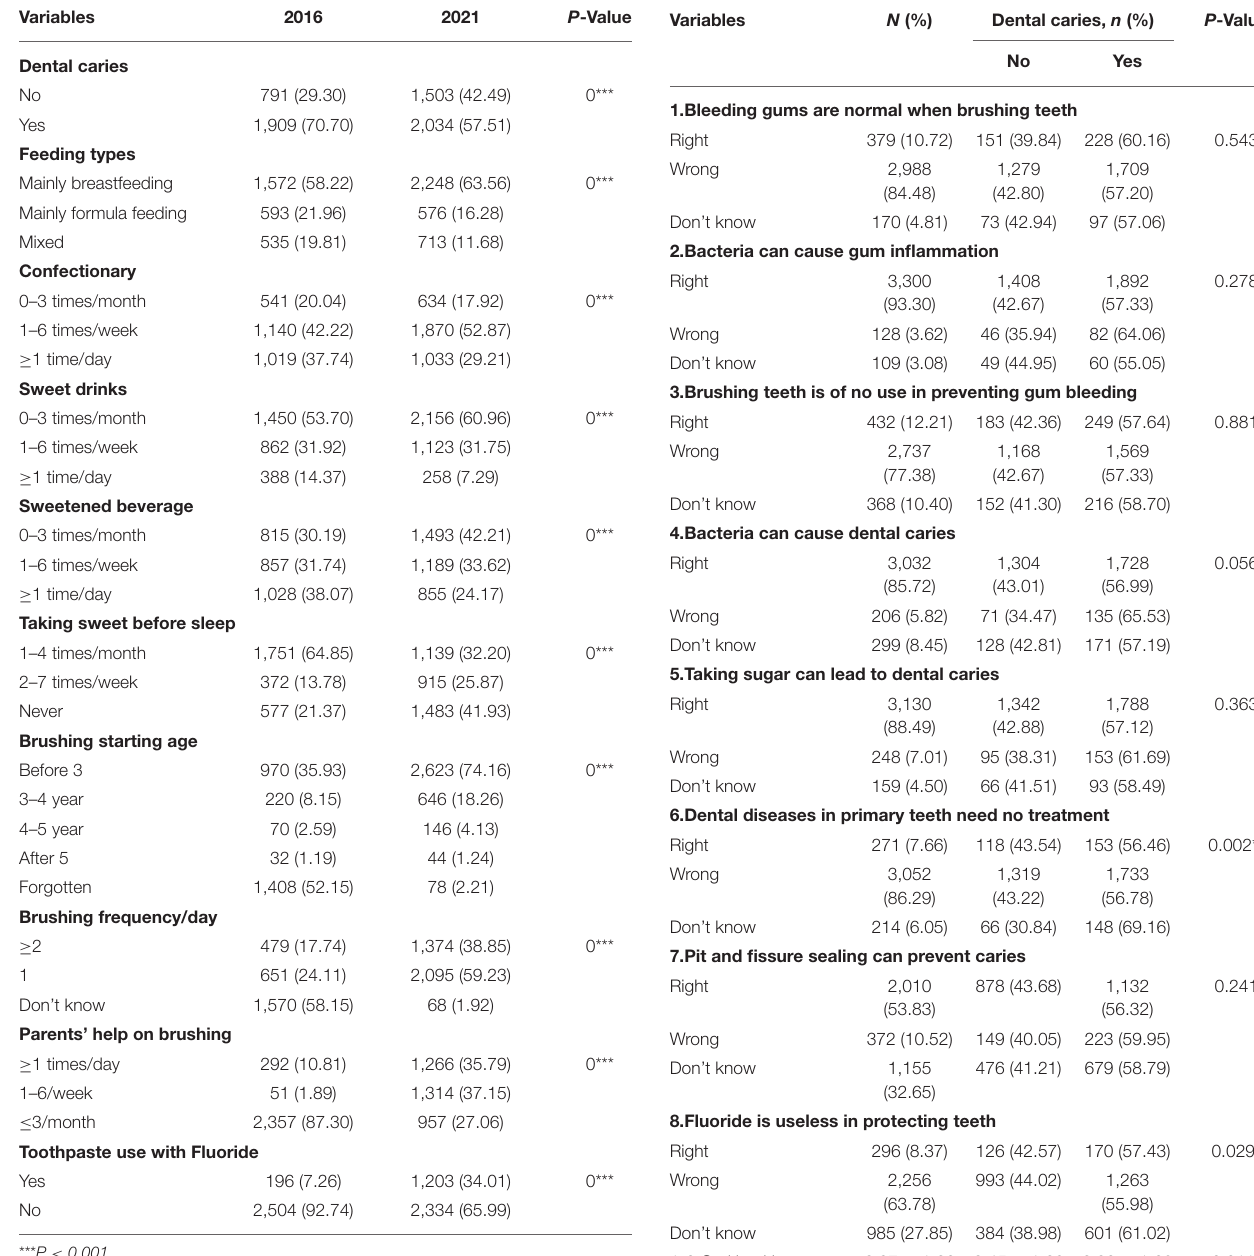
TABLE 3 | Response distribution on parents’ understanding of oral health knowledge regarding